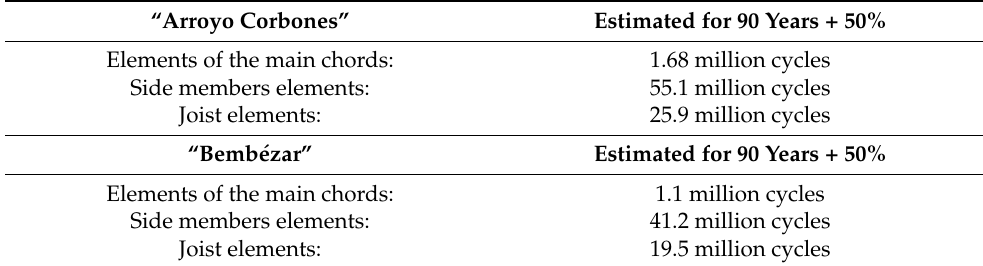
Table 1. Accumulated no. of load cycles on the bridges (expressed as no. of cycles). “Arroyo